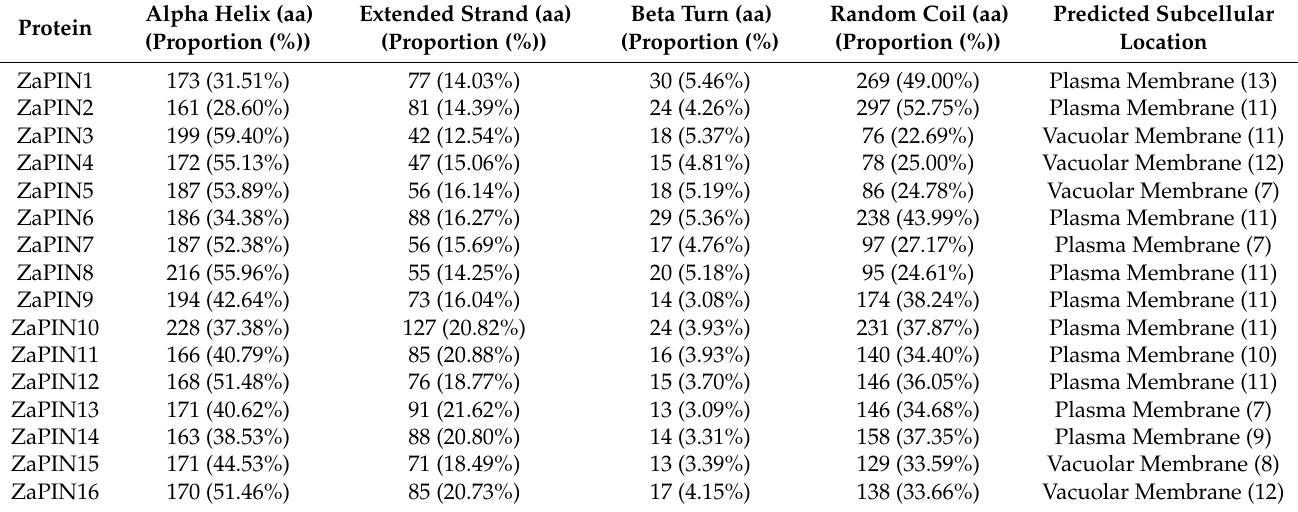
Table 3. Predicted secondary structure and subcellular location of